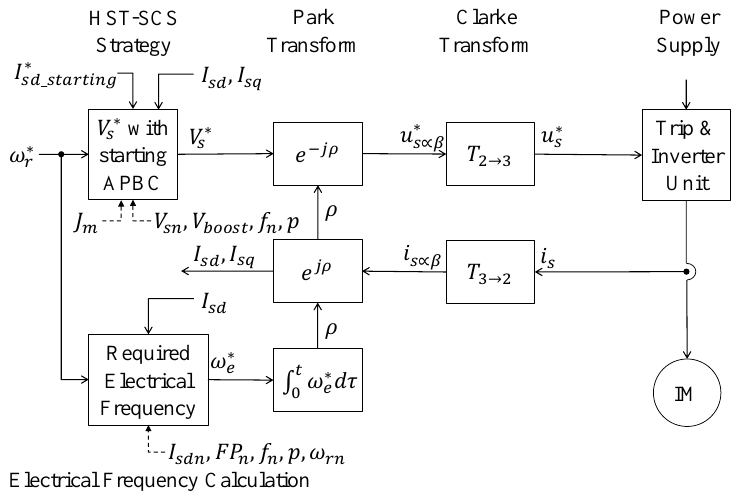
Figure 1. General block diagram of the HST-SCS for IMs, based on